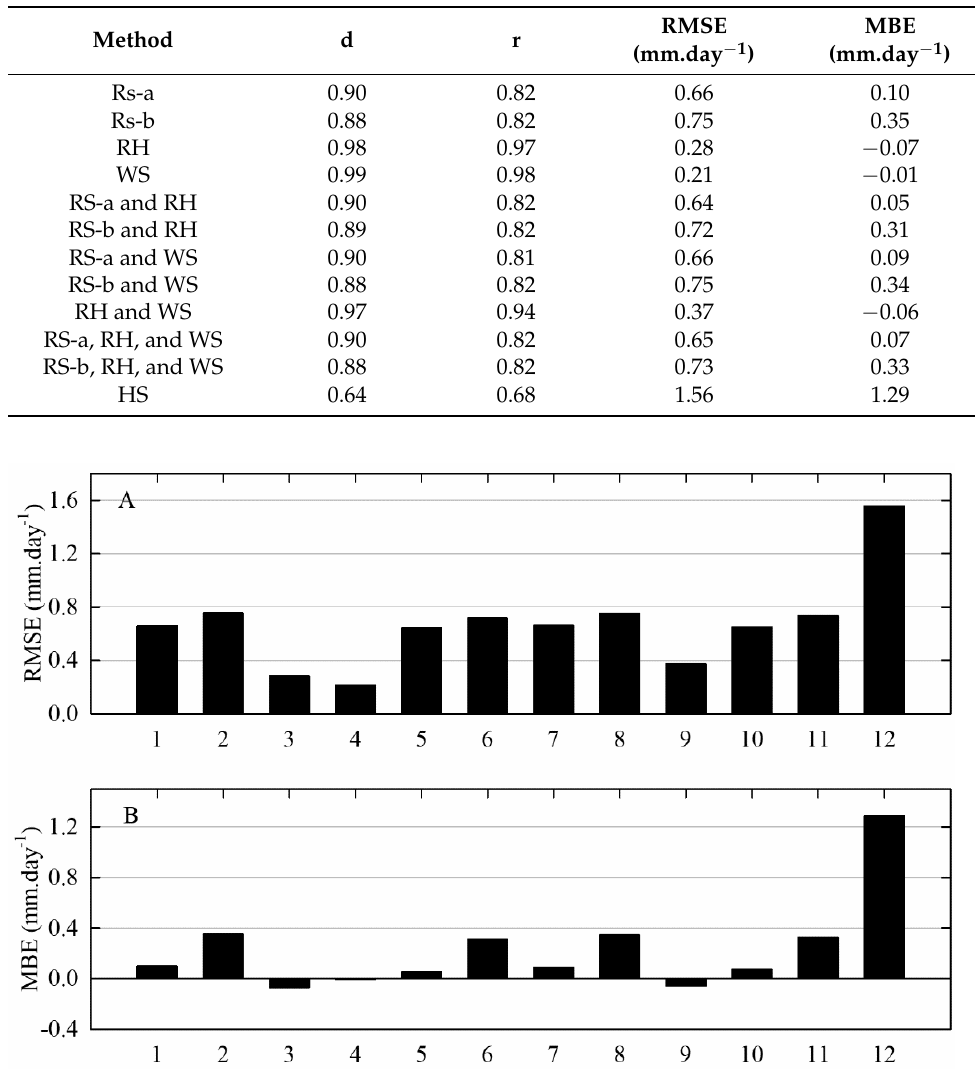
Figure 5. ( A ) Root mean square error (RMSE) and ( B ) mean bias error (MBE) of computed ET o using estimates of (1) Rs-a; (2) Rs-b; (3) RH; (4) WS; (5) Rs-a and RH; (6) Rs-b and RH; (7) Rs-a and WS; (8) Rs-b and WS; (9) RH and WS; (10) Rs-a, RH, and WS; (11) Rs-b, RH, and WS; and (12) HS.